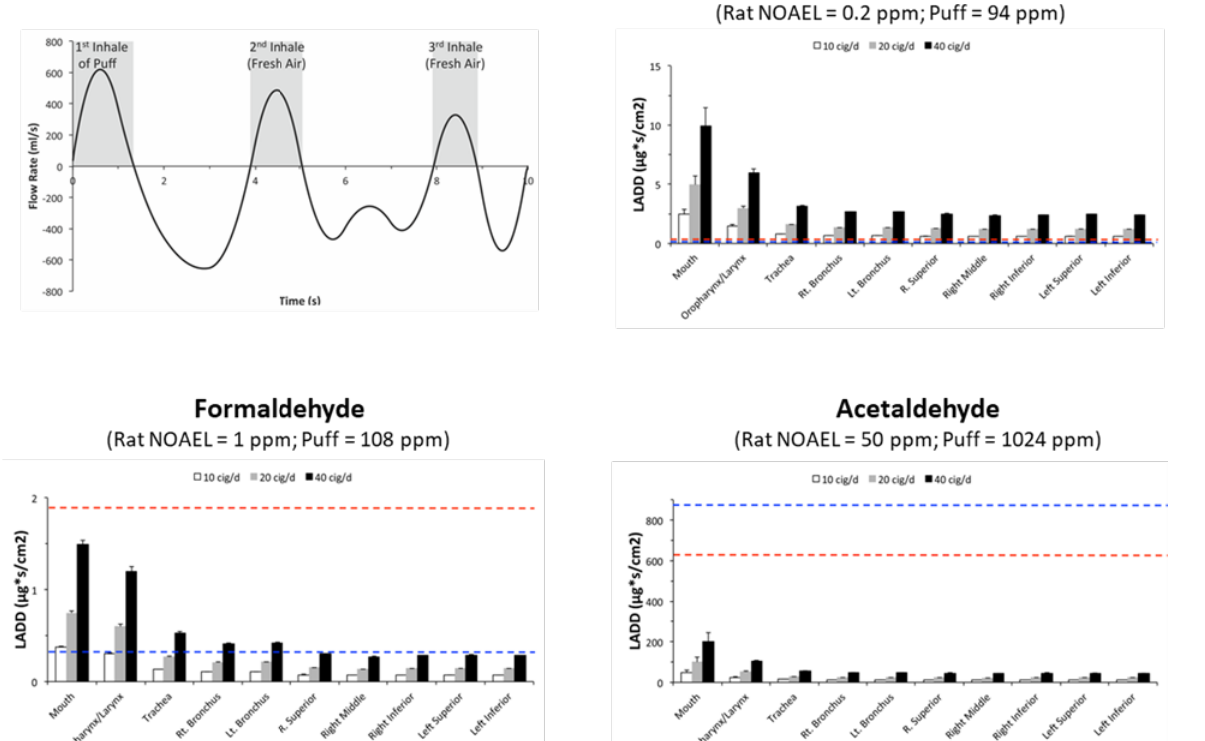
Figure 5. Comparisons of lifetime average daily doses (LADD) in rat respiratory (blue dashed lines) and olfactory (red dashed lines) nasal tissues determined by CFD/PBPK modeling at NOAEL’s from acrolein, formaldehyde, and acetaldehyde sub-chronic inhalation studies for each airway region of a human smoker, assuming 10, 20, or 40 cigarettes smoked per day (from [64]; part of NAM-03 presentation, Supplemental File).